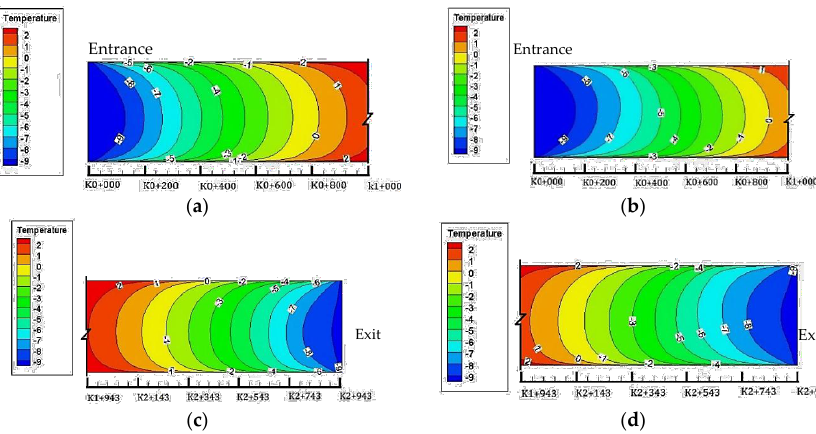
Figure 9. Average airflow temperature contours in December in the tunnel entrance and exit sections. ( a ) Tunnel entrance section without heat-insulating layer; ( b ) Tunnel entrance section with heat-insulating layer covering K0 + 000–K0 + 700; ( c ) Tunnel exit section without heat-insulating layer; and ( d ) Tunnel exit section with heat-insulating layer covering K2 + 343–K2 +